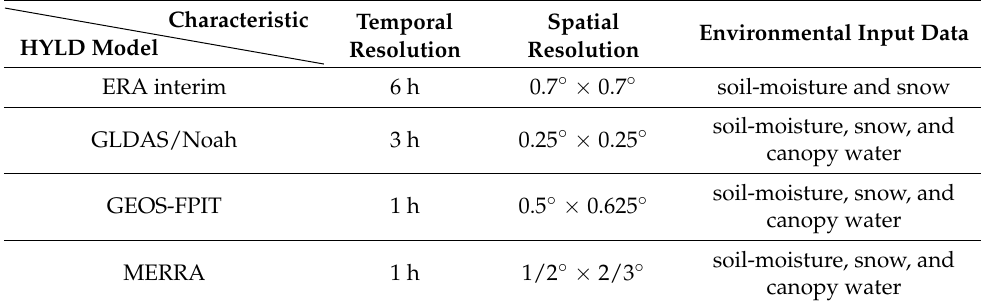
Table 1. HYLD models and their